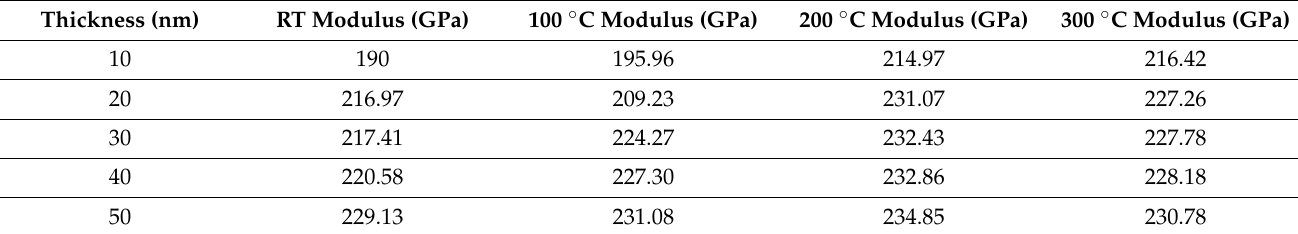
Table 3. Young’s modulus of CoFeYb films.